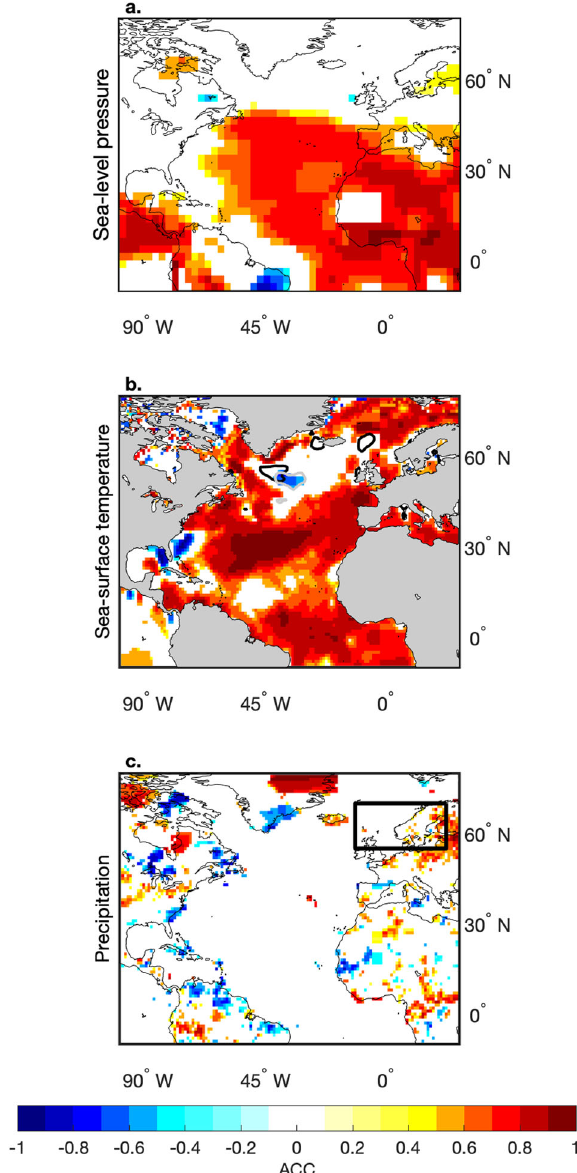
Fig. 3 Maps of predictability in the Atlantic region. We map ACC values for a sea-level pressure, b SST, and c precipitation. We display only the raw ensemble mean. We only color those pixels with ACC values that are statistically signi fi cant at the 95% level. In panel b , highlight the location of the warming hole by contouring the − 1 °C/ 54-year trend in SST in observations (black) and our ensemble (gray). In panel c , we highlight the location used to calculate Northern European precipitation reported in the